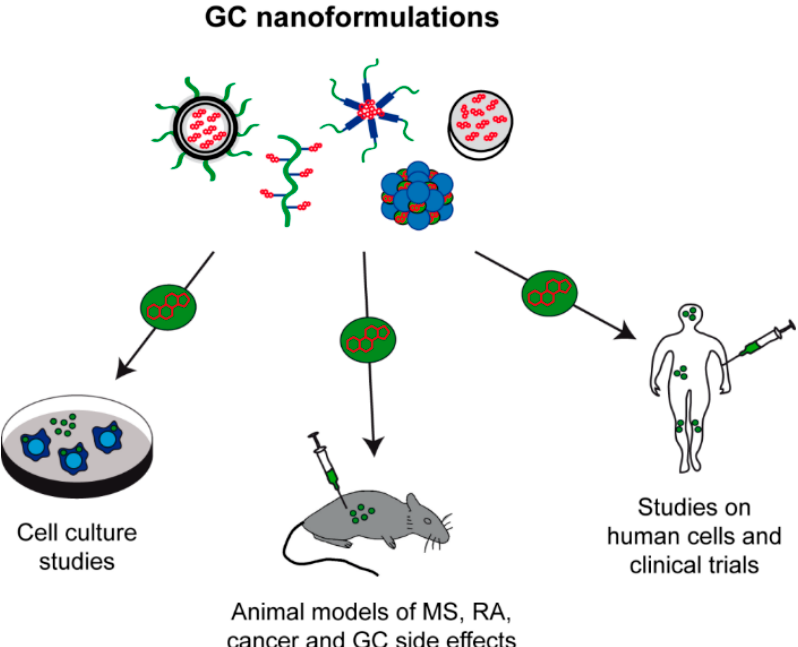
Figure 3. Current state of preclinical and clinical research on GC nanoformulations. Liposomes, polymeric micelles, polymer-drug conjugates, inorganic materials and IOH-NP have been intensively tested in vitro and in vivo. The majority of analyses were performed in animal models of various diseases including multiple sclerosis (MS), rheumatoid arthritis (RA), cancer and GC-related side effects, but translational studies in human cells were also started and even a few clinical trials were already initiated. However, none of the current concepts made it into clinical practice so far.